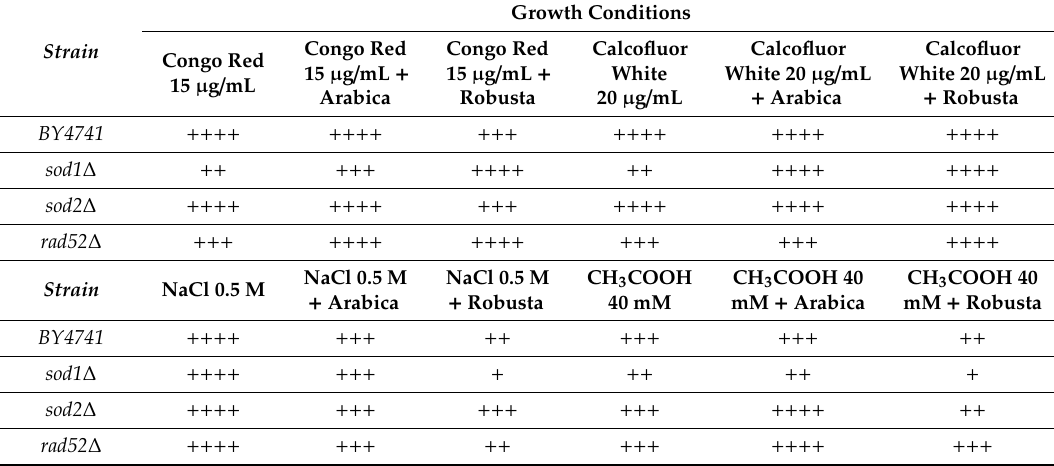
Table 3. Sensitivity of the BY4741 strain and isogenic mutant strains sod1 Δ , sod2 Δ and rad52 Δ treated with Arabica or Robusta coffee infusions on cells stressed factors.